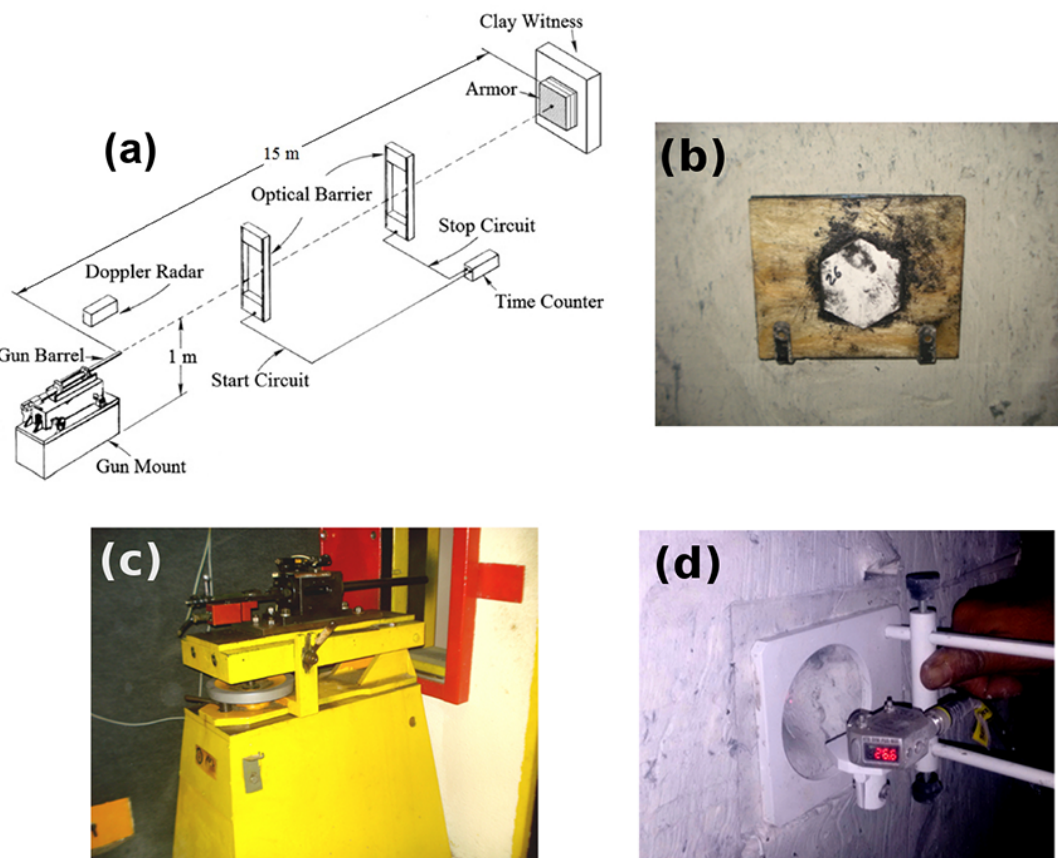
Figure 1. Ballistic test: (a) Schematic diagram with the experimental arrangement; (b) MAS positioned in front of the clay witness; (c) Gun barrel with laser sight; (d) Measurement of the indentation after the impact.